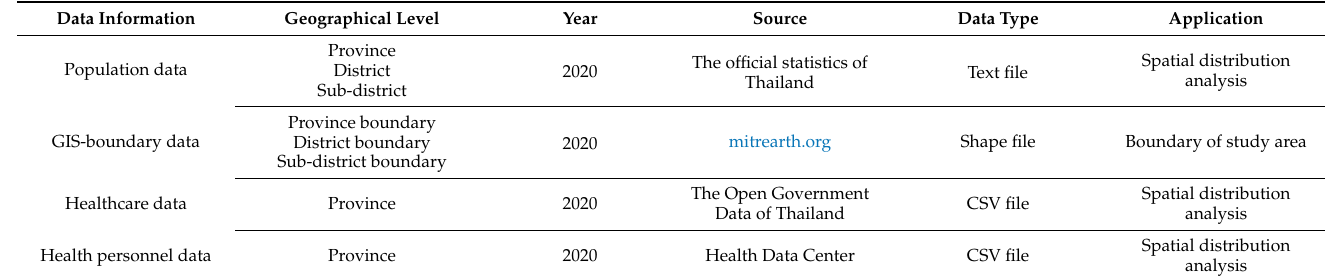
Table 1. Collected data for the